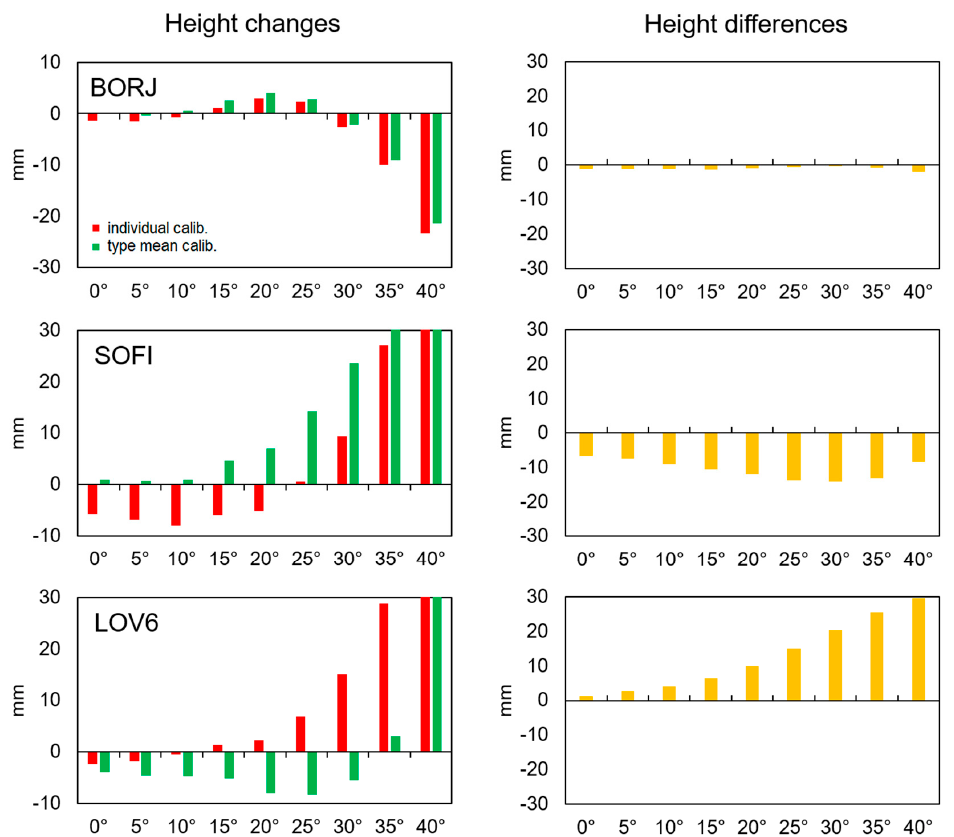
Figure 4. On the left, height changes related to applied elevation mask are shown. For each station, the reference height was calculated as a weighted average from all 18 solutions. On the right, height differences between corresponding solutions are shown (green − red).